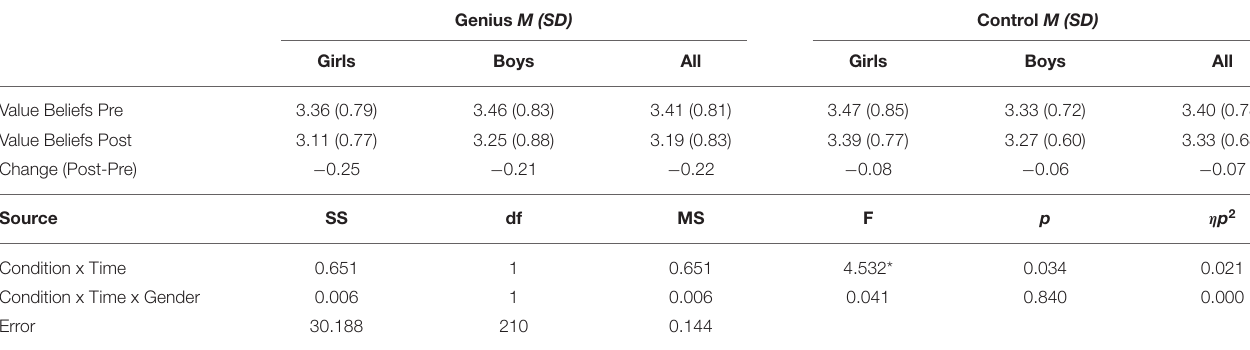
TABLE 2 | Condition by time by gender